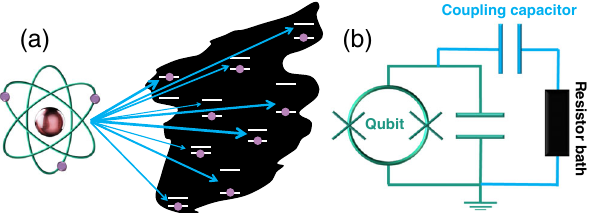
FIG. 1. Schematic illustration of an open quantum system. (a) The system is linearly coupled to oscillators forming the bath with distributed couplings and energies. (b) Physical realization of (a) with corresponding colors, in the form of a superconducting qubit coupled capacitively to a